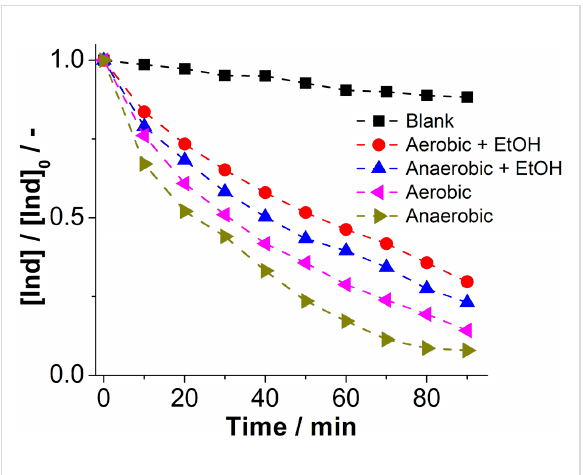
Figure 3: Photooxidative performance of 1 depending on the pres- ence of EtOH under aerobic and anaerobic conditions for the homoge- neous photooxidation of indigo (Ind). Solvent: DMF (aerobic/ anaerobic), light source: monochromatic LED ( λ = 430 nm, P nominal = 3 W), [EtOH]:[1] = 50:1.